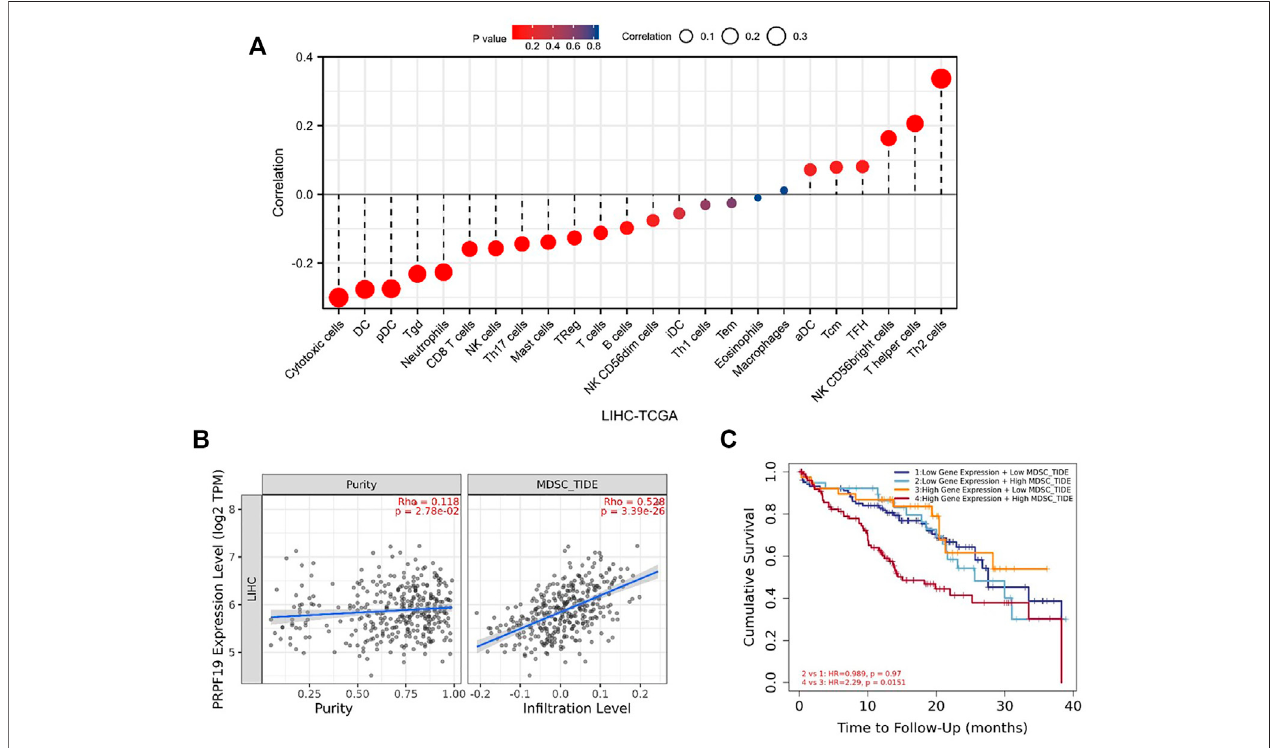
FIGURE 4 | Correlation analysis of PRPF19 level and immune microenvironment in LIHC. (A) PRPF19 expression in LIHC tissues negatively correlates with 17 immunecelltypes. (B) CorrelationbetweenPRPF19andin fi ltratedmyeloid-derivedsuppressor cells(MDSC)inLIHC. (C) KMcurvesaccordingPRPF19expressionand MDSC in fi ltrating level in LIHC. Data shown as mean ± SD. * p < 0.05, ** p < 0.01, *** p <